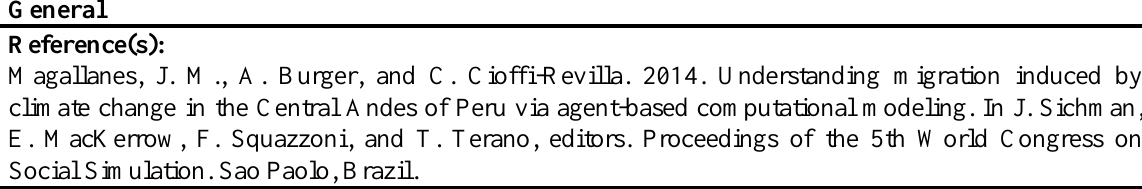
Table A1.6 Standardized protocol for the ABM described by Magallanes et al.